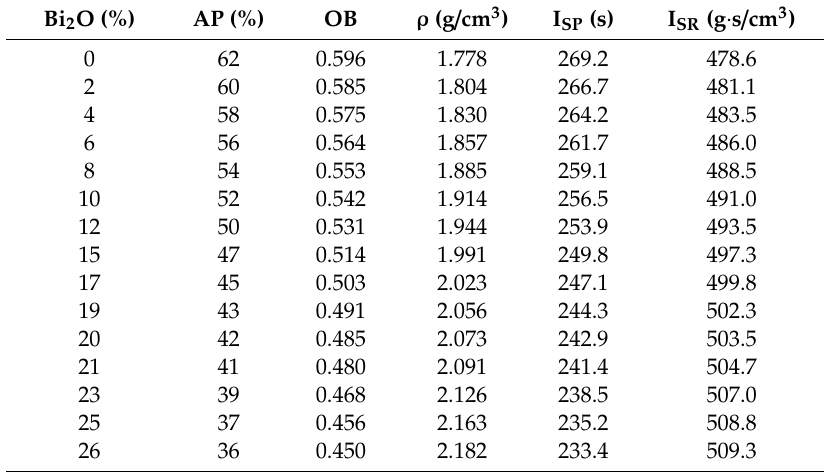
Table 4. E ff ect of Bi 2 O 3 content on energy performances of the HTPE propellant systems with the same solid